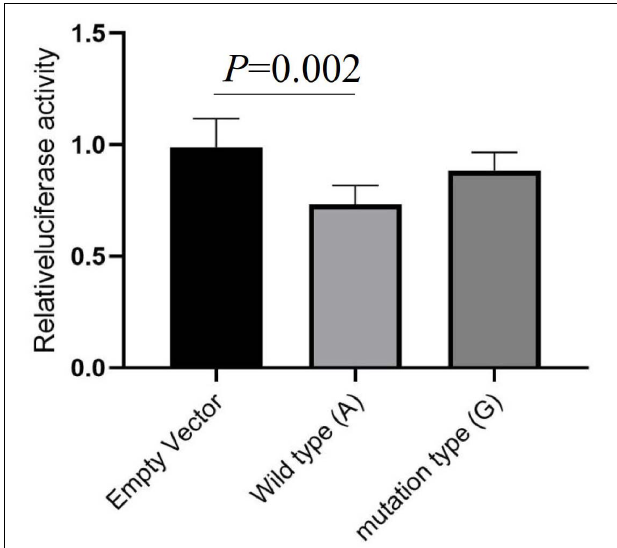
FIGURE 1 | Luciferase reporter assay evaluates the effect of rs13306146 on α 2 A AR transcriptional activity. The A allele of rs13306146 decreases α 2 A AR transcription activity in HeLa cell. Data were presented as mean ± SD with the replication of n =